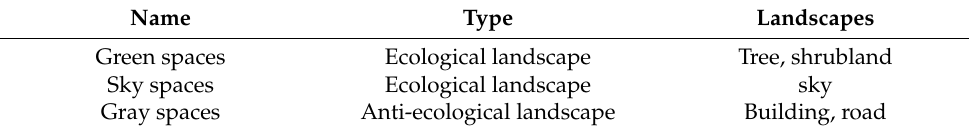
Figure 3. The distribution of collected sampling points in Xiamen Island.